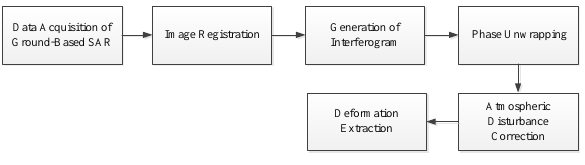
Figure 5. Mean amplitude intensity